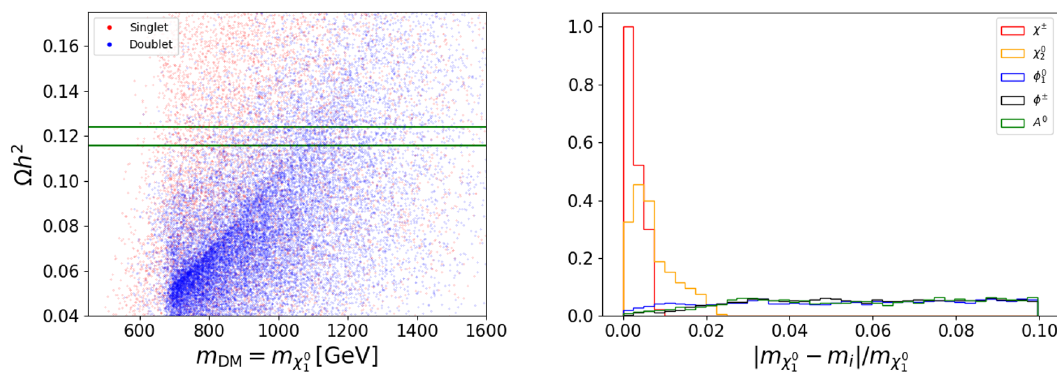
Figure 11 . Left: correlation of the fermion dark matter relic density and the fermion dark matter mass obtained from a random scan without imposing the experimental constraints of table 4. Blue points correspond to doublet-dominated fermions, while red points indicate singlet-dominated configurations. The horizontal lines are the Planck limits for the relic density. Right: mass difference between the heavier neutral fermion, charged fermion, the lightest scalar, charged scalar, and the pseudo-scalar with respect to the lightest fermion mass for the case where the lightest fermion is the dark matter candidate using the MCMC